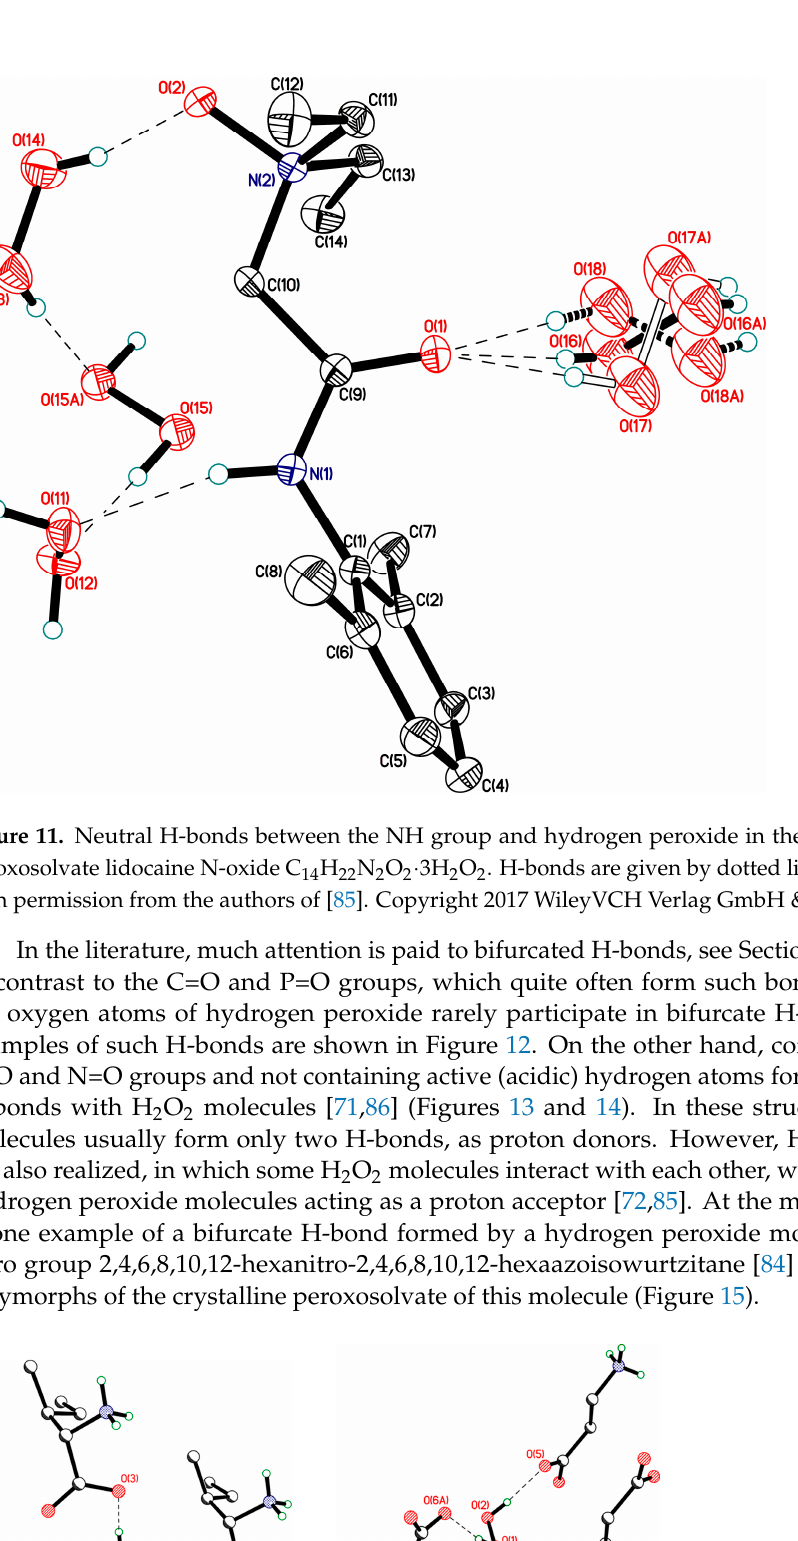
Figure 13. Single crystal structure of (p-Tol 3 PO·H 2 O 2 ) 2 . Reproduced from the work in [71] with permission from The Royal Society of Chemistry.